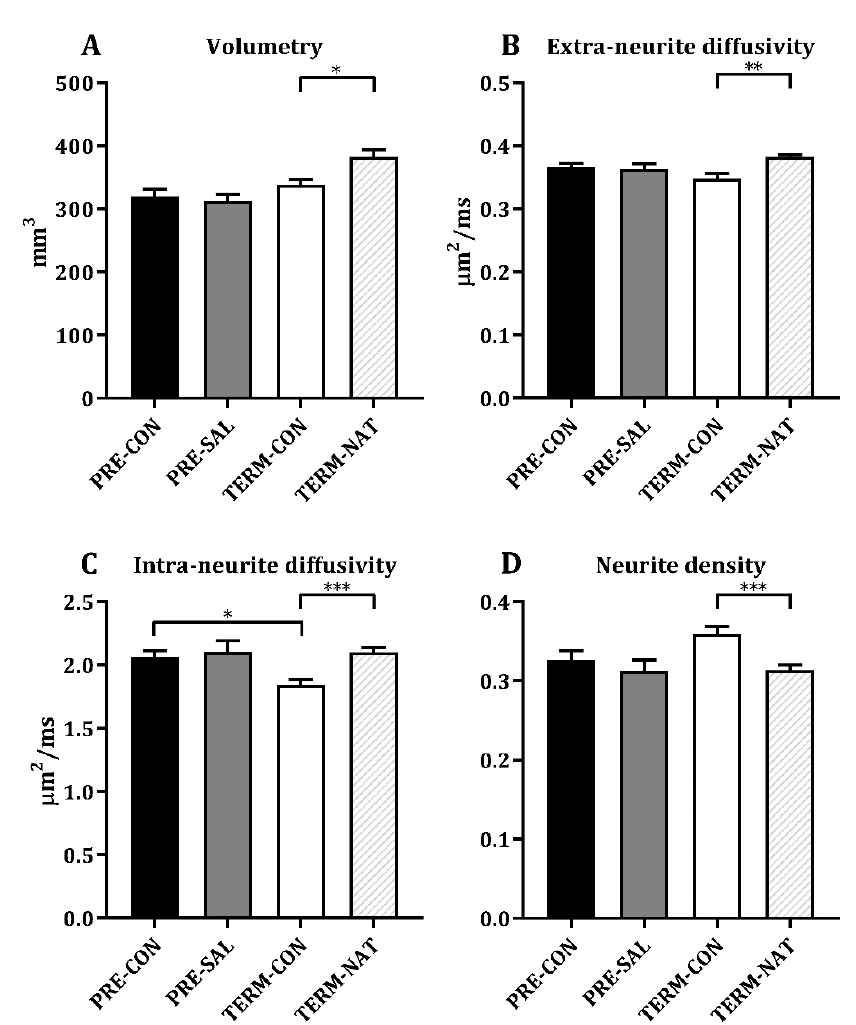
Figure 4. Hippocampus measurements after magnetic resonance imaging; volumes ( A ), extra-neurite diffusivity ( B ), intra-neurite diffusivity ( C ), and neurite density ( D ). Data are presented as mean ± SEM, n = 10 for all groups. Statistical difference * p < 0.05; ** p < 0.01; *** p < 0.001.